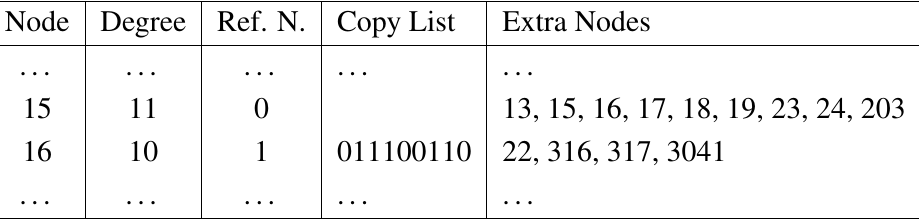
Table 1. The Boldi and Vigna representation using copy lists [3].